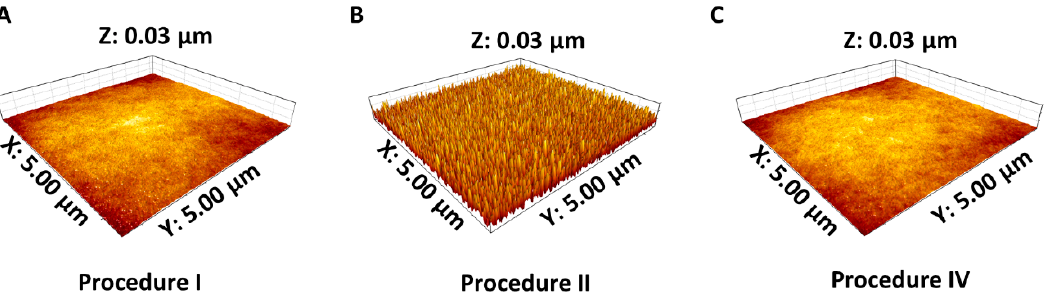
Figure 7. AFM images of samples after ( A ) molding (Procedure I), ( B ) plasma etching (Procedure II), and ( C ) post-baking at 250 °C for 10 min (Procedure IV).